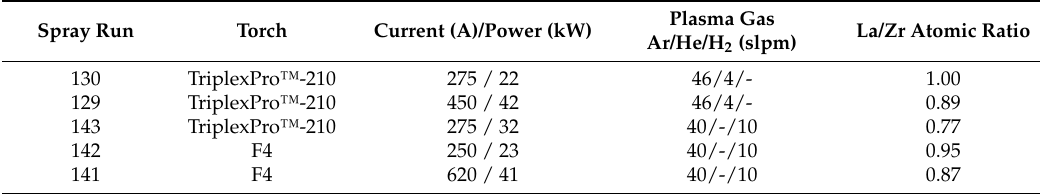
Table 2. Plasma parameters and corresponding results of the chemical analyses of the coating stoichiometry (spray distance 90 mm, powder 321 M, feed rate 8 g/min); slpm: standard liters per minute.